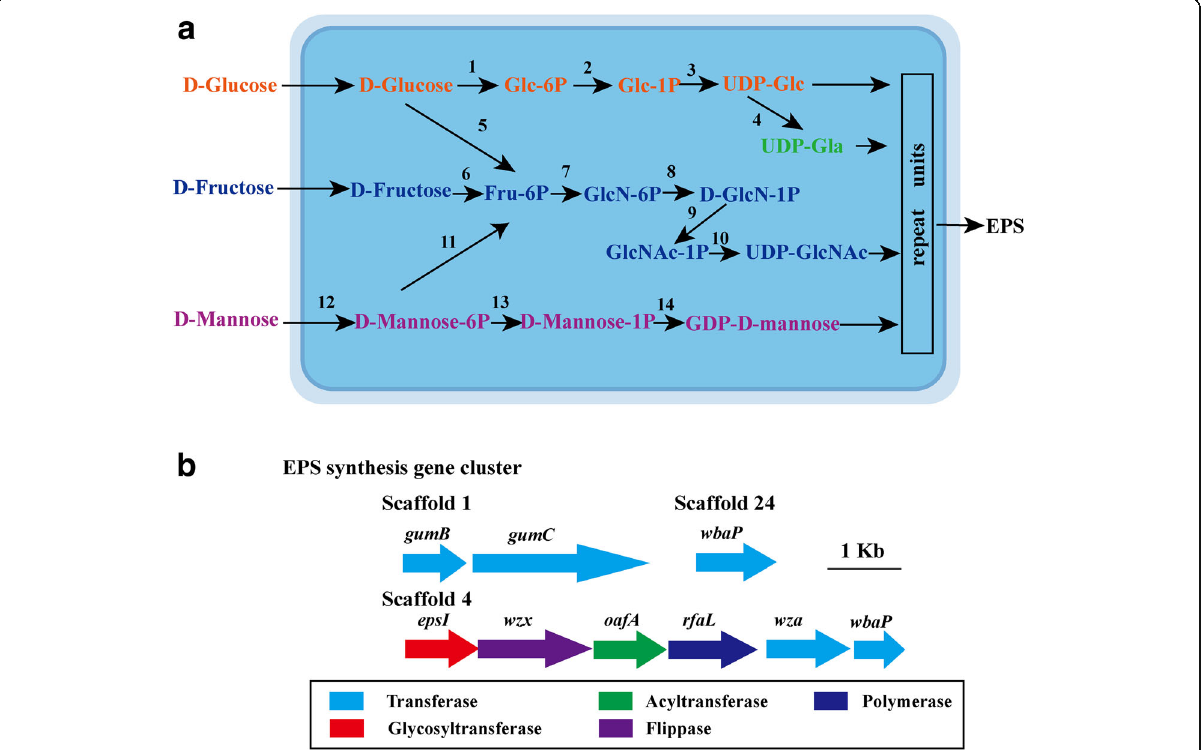
Fig. 4 Putative nucleotide sugars biosynthesis pathway and EPS synthesis gens in P. manganicus JH-7 T . a The predicted nucleotide sugars biosynthesis pathway. The numbers refer to the enzymes involved: 1, Glucokinase; 2, α -D-glucose phosphate-specific phosphoglucomutase; 3, UTP--glucose-1-phosphate uridylyltransferase; 4, UDP-glucose 4-epimerase GalE; 5, Glucose-6-phosphate isomerase; 6, Fructokinase; 7,